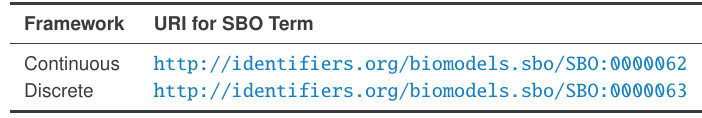
Table 11: SBO terms to specify the framework property of a Model